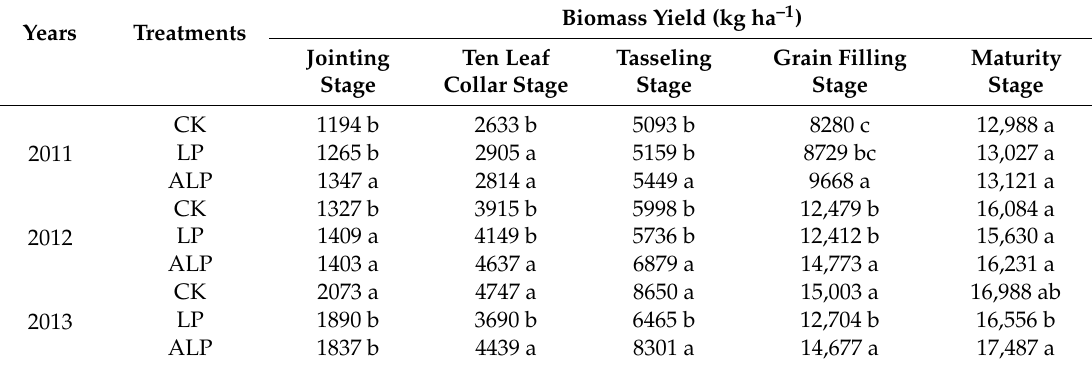
Table 3. E ff ects of di ff erent straw incorporation treatments on biomass yield at di ff erent growth stages of summer maize.